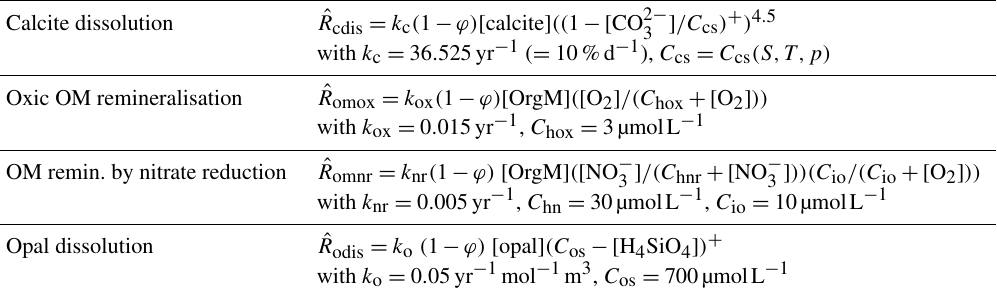
Table 4. Reaction rate law expressions adopted for COUPSIM and parameter values for the experiment depicted in Fig. 4 (represented by the full symbols in Fig. 3). Units and notations are the same as in Table 3. In addition, C hnr is the half-saturation concentration of NO − C io the characteristic inhibition concentration of O 2 for the oxidation of organic matter by nitrate